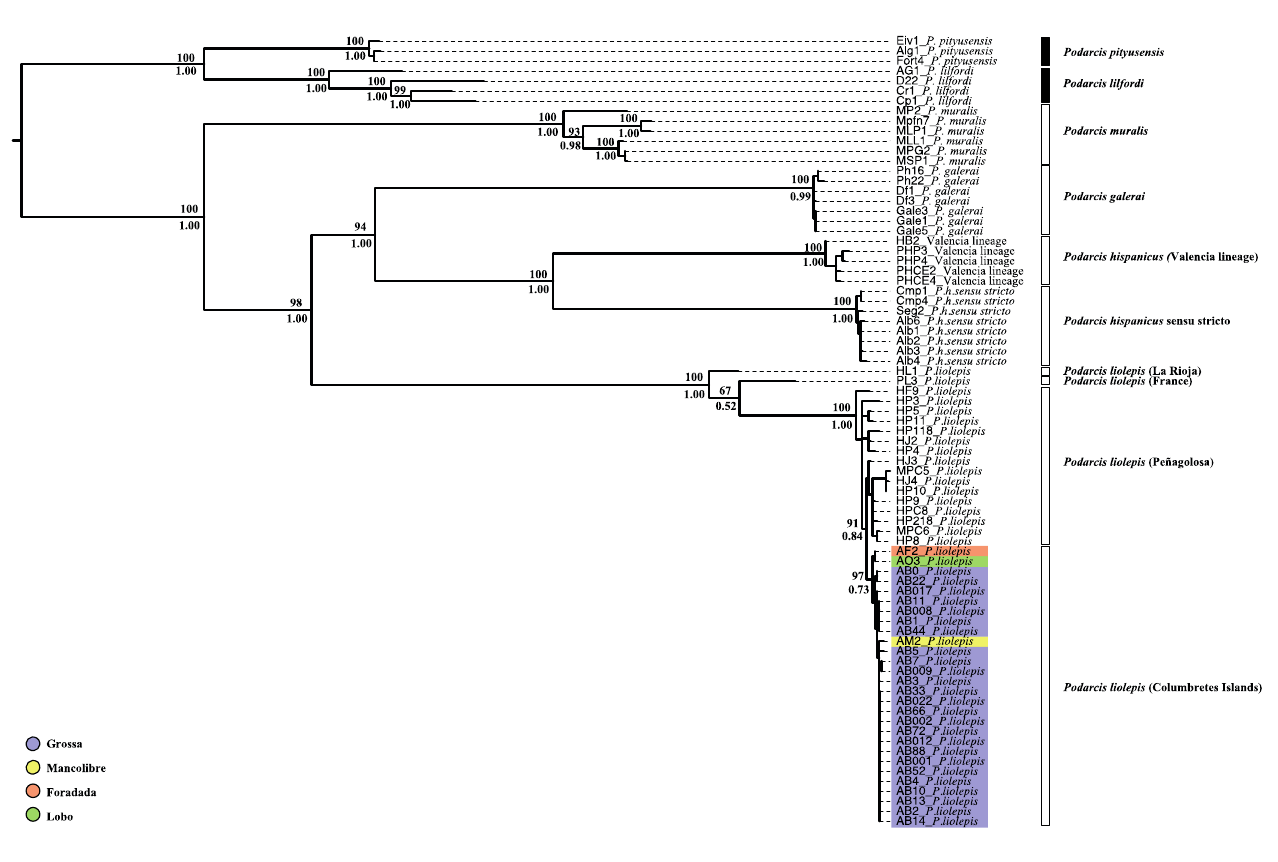
Figure 4. Gene tree based on ML for mitochondrial data showing the close position of Columbretes Island samples to P. liolepis from Peñagolosa, Spain. The Balearic clade was used as an outgroup. The numbers above the branches correspond to bootstrap support and the numbers below the branches are posterior probabilities from Bayesian analysis.